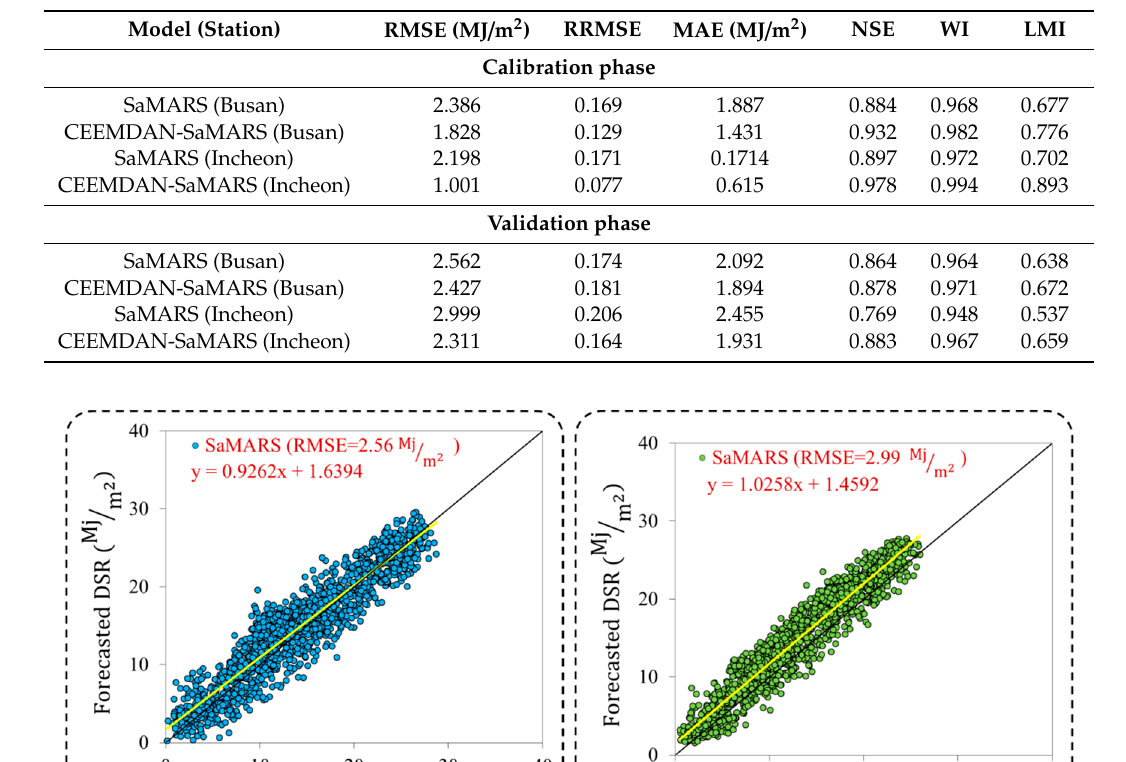
Table 5. Statistical performance of standalone and hybrid SaMARS models at Busan and Incheon stations.